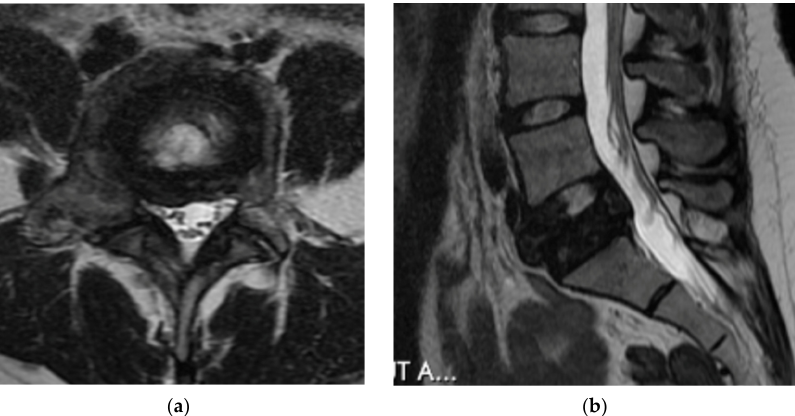
Figure 7. ( a ) L5 Giant Cell Tumor after 6 months of IV denosumab treatment. T2 weighted axial MRI cuts of L5 vertebral body show normalized bone marrow signal intensity when compared to pre- denosumab imaging. ( b ) Sagittal T2 weighted cuts of L5 Giant Cell Tumor after 6 months of IV denosumab therapy show reduction of retropulsion into the canal likely secondary to consolidation of tumor.